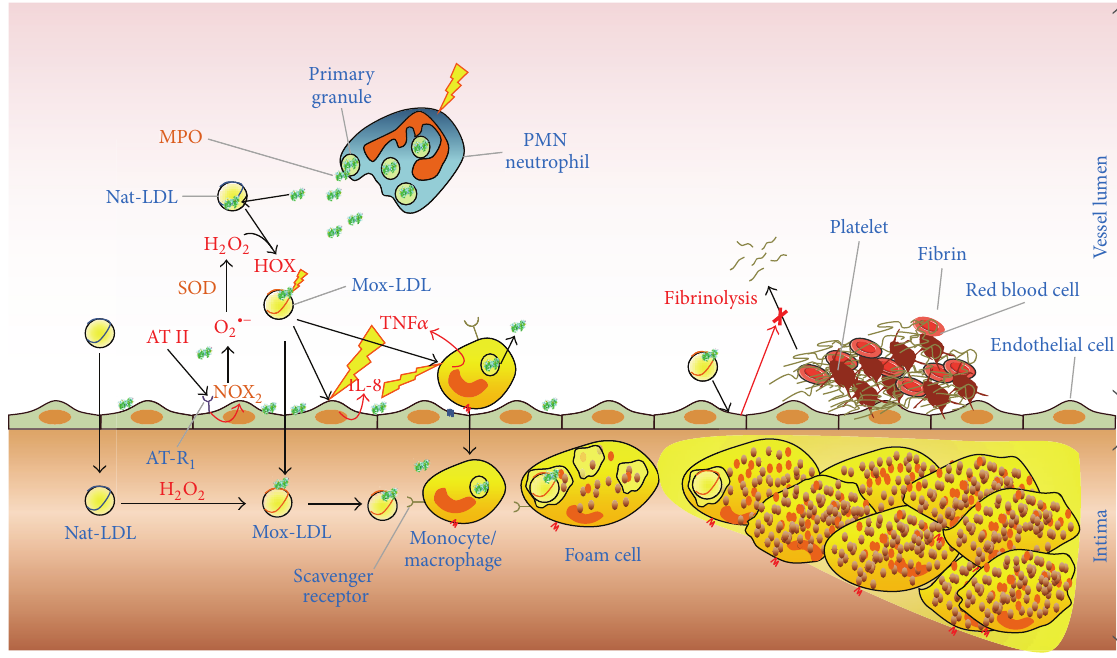
Figure 2: Role of myeloperoxidase and Mox-LDL in triggering inflammation and atherosclerosis plaque formation. Activation of neutrophils and monocytes leads to MPO release in the extracellular space, that is, the circulation. Due to its cationic properties, free MPO rapidly adsorbs at the surface of endothelial cells or native LDL (Nat-LDL). Angiotensin II (AT II) activates endothelial cells via angiotensin receptor 1 (AT- R1), which in turn produces superoxide anion (O 2∙− ) via the NADPH oxidase complex, (NOX2). O 2∙− is rapidly transformed into hydrogen peroxide (H 2 O 2 ) spontaneously or by the enzyme superoxide dismutase (SOD). Nat-LDL can be so directly oxidized by MPO/H 2 O 2 /chloride system in the circulation and form the so-called Mox-LDL. The latter can in turn pass through the endothelium (due to endothelial dysfunction) to the subendothelial space where it will be recognized by macrophages and eliminated. Accumulation of oxidized lipoproteins leads to foam cell formation and lipid accumulation in the subendothelial space. Nat-LDL, can also directly pass through the endothelial wall where they are oxidized by MPO in the subendothelial space. Finally, LDL oxidized by myeloperoxidase (Mox-LDL) activates endothelial cells and induces interleukine-8 (IL-8) secretion by these cells. Mox-LDL effects on monocyte are similar and activate tumor-necrosis factor- 𝛼 (TNF 𝛼 ) secretion by these cells. In turn, IL-8 and TNF 𝛼 activate monocytes and endothelial cells, respectively. Mox-LDL also inhibits fibrinolysis process via endothelial cell